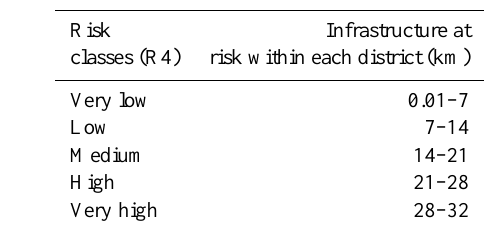
Table 13. Relative risk classes and range of values for infrastruc-